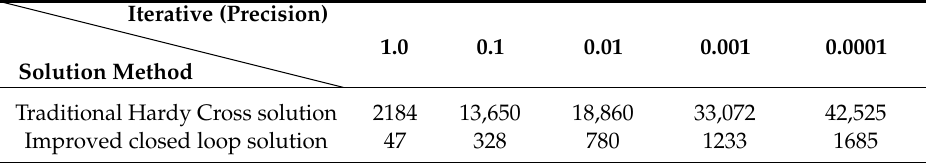
Table 5. Comparison of the iterative time (ms) for di ff erent specified iterative precisions (m 3 / s) using the traditional Hardy Cross solution method with the improved closed loop solution